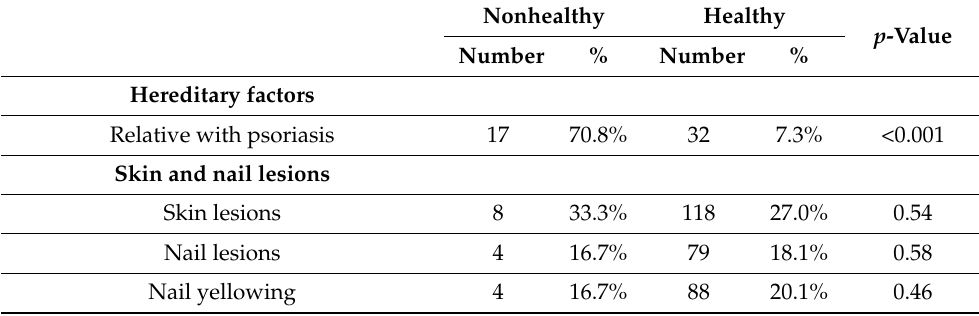
Table 5. Results and data analysis of the national study (N = 1500